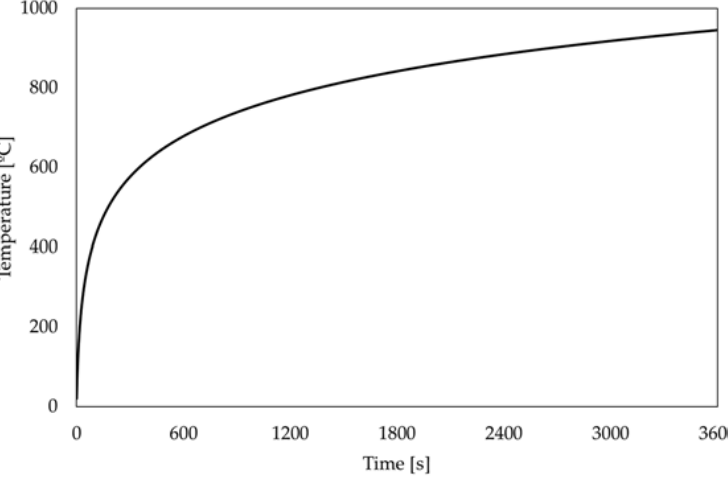
Figure 6. Nominal temperature–time curve ISO 834.